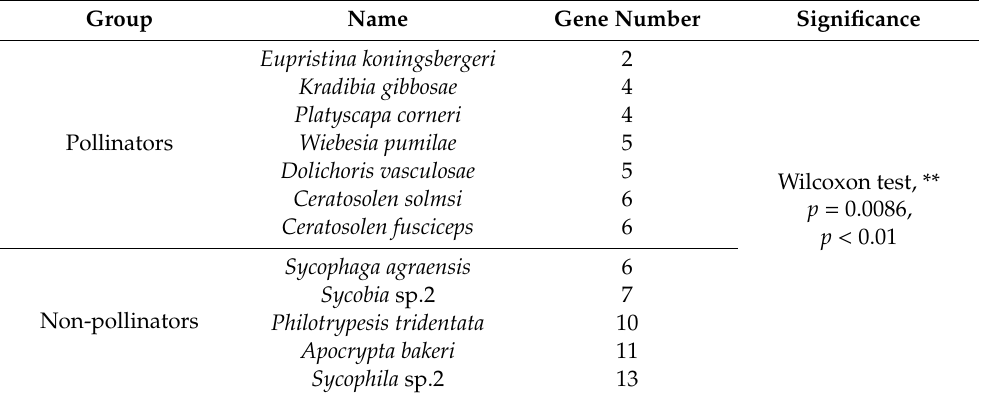
Wilcoxon test, ** p = 0.0086, p < 0.01